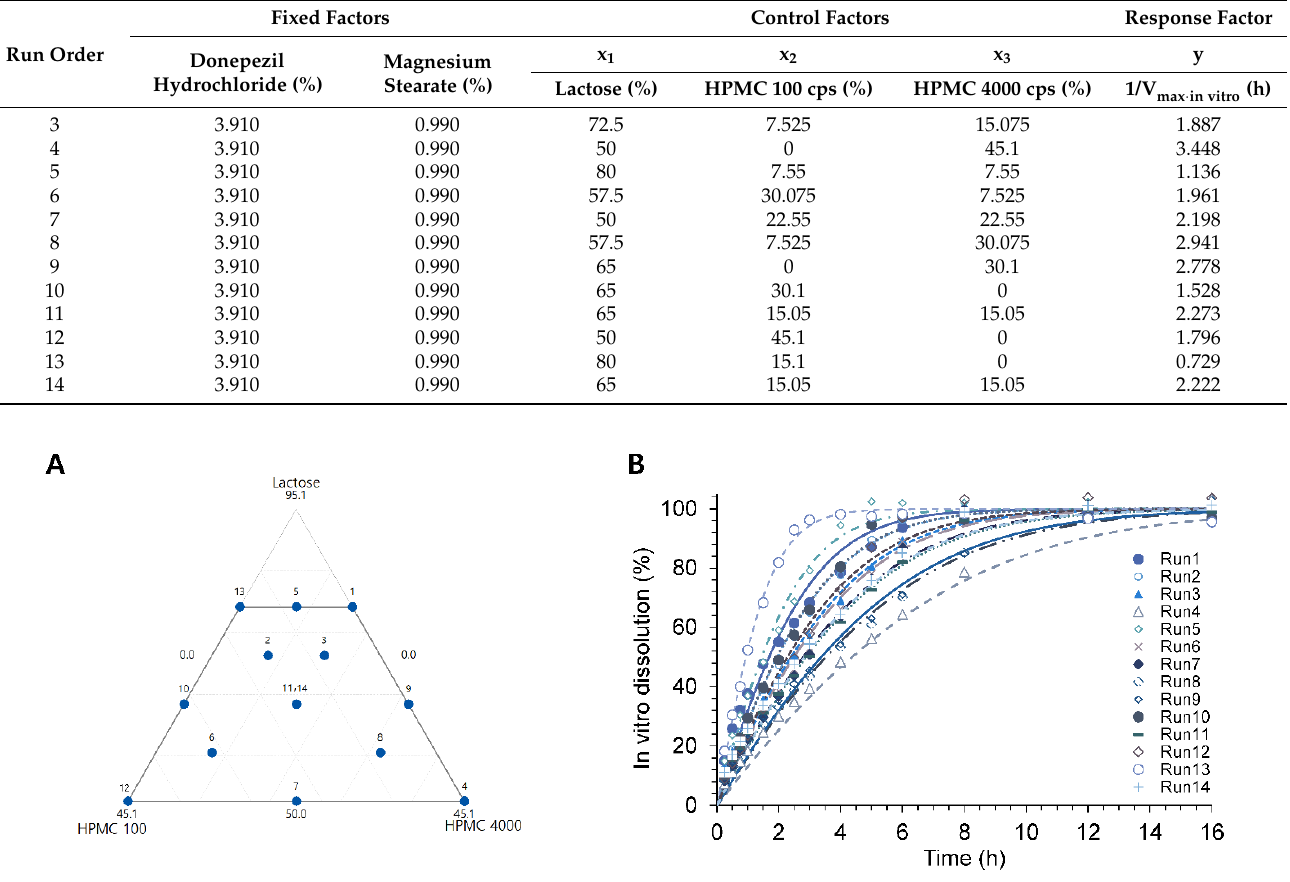
Figure 1. Fourteen experimental points of donepezil SR tablets on the simplex design plot ( A ) and the respective in vitro dissolution profiles at pH 1.2 ( B ).